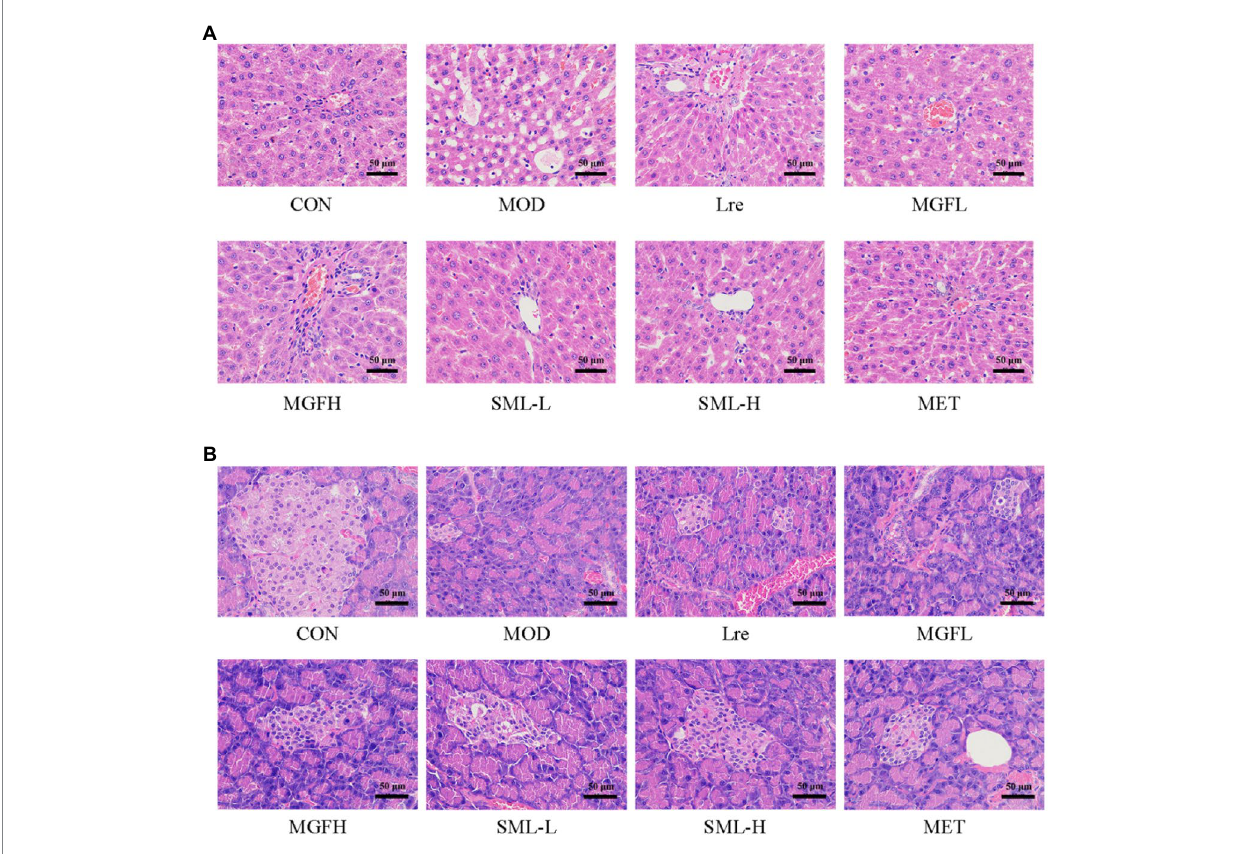
FIGURE 3 Photomicrographs. (A,B) were representative photomicrographs of the liver and pancreas, respectively (original magnification 200 ×).